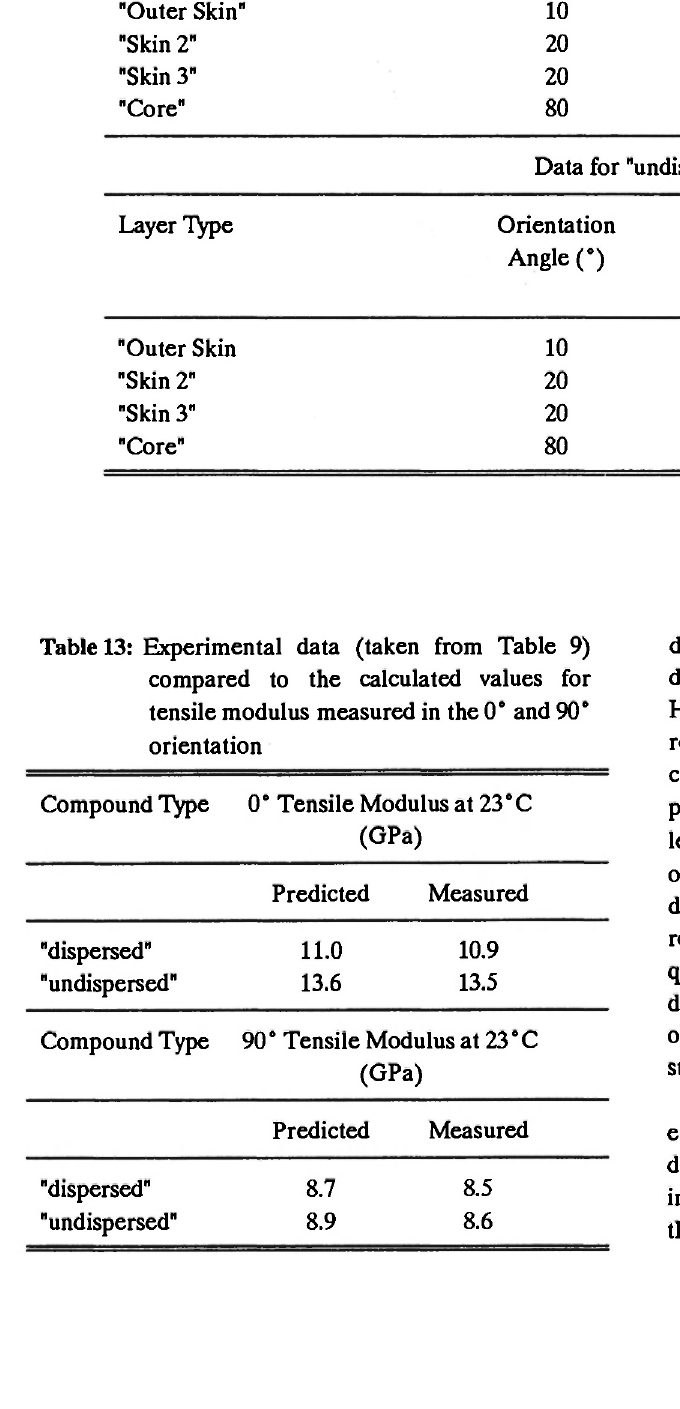
Table 13: Experimental data (taken from Table 9) compared to the calculated values for tensile modulus measured in the 0° and 90°